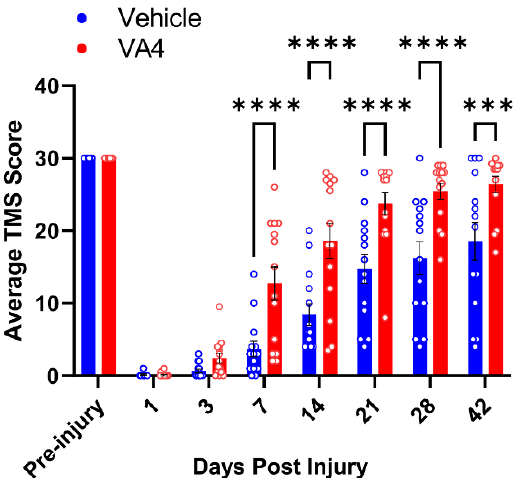
Figure 9. Treatment with the TG2 inhibitor VA4 improves functional recovery after spinal cord injury (SCI). Wild type mice at 12–16 weeks of age (14 mice in each group) were anesthetized and subjected to SCI as in Figure 1. Mice were administered VA4 at 15 mg/kg i.p. 1 h post-injury and then at 24 and 48 h. Control animals received Cremaphor only. Motor function was assessed prior to injury and at the days indicated post-injury using the Toyama mouse score (TMS) to assess locomotor function [25]. Data are expressed as an average of the right hind limb and left hind limb. Data were analyzed by two-way ANOVA with Bonferroni’s multiple comparisons test, *** p < 0.001, **** p <